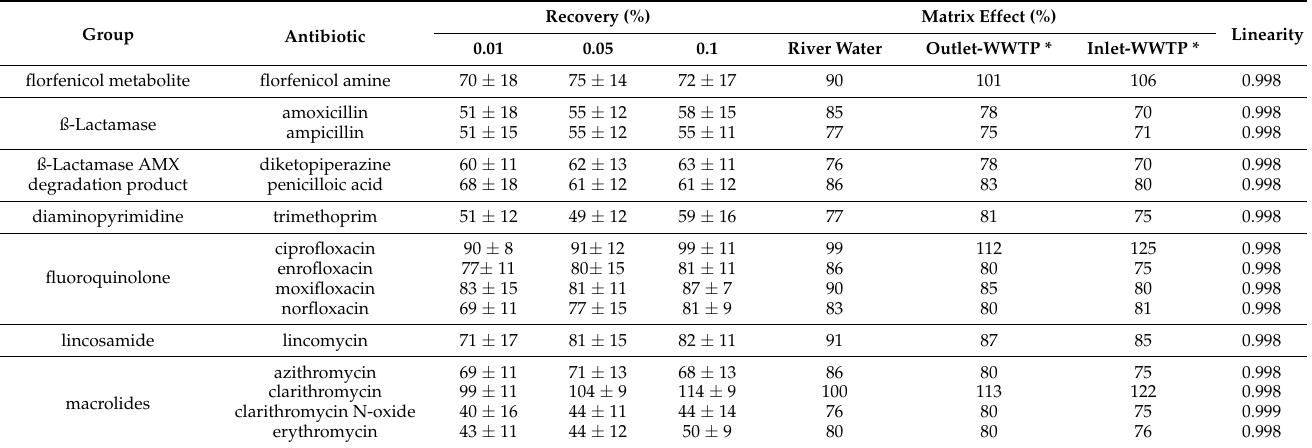
Table A1. Recovery and matrix effect data for the developed procedure; * WWTP—water from wastewater treatment